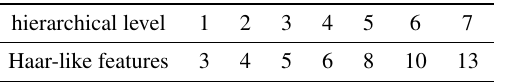
Table 1: Distribution of features used in the hierarchical detector